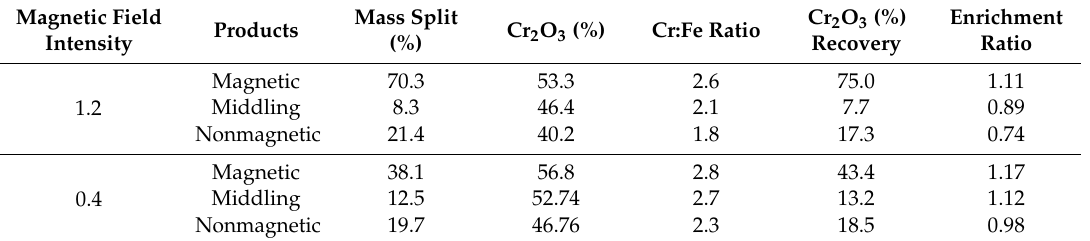
Table 7. Results of the two-stage separation in the WHIMS for the coarse concentrate.